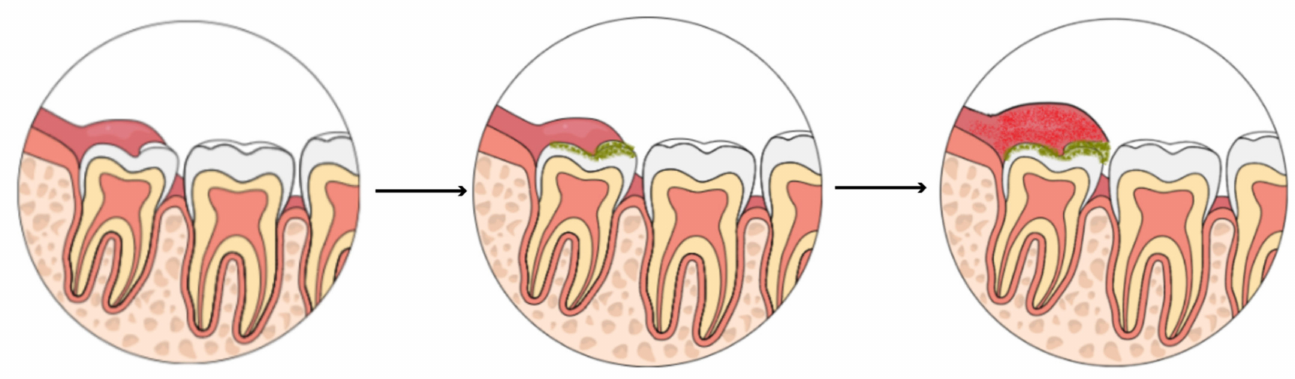
Figure 1. Pericoronitis development—illustrative scheme. Images demonstrate a partially erupted third molar covered by soft tissue. Plaque and detritus (green) stagnation lead to soft tissue